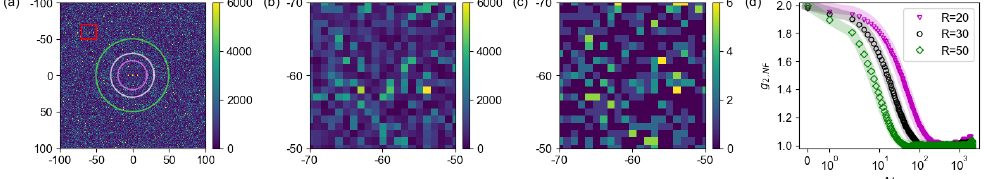
Figure 1. ( a ) The 100-th “noise-free” speckle pattern generated from the Fourier transform of the 2D diffusion simulation. Three annular ROIs were plotted with a radius of R = 19 ∼ 21 (purple), R = 29 ∼ 31 (gray) and R = 49 ∼ 51 (green) respectively. We refer to these ROIs as R = 20, R = 30 and R = 50 hereafter in the texts and in the legends. The R = 30 ROI will be used in the XPCS analysis in Figures 2–7. ( b ) A zoomed-in view of the red boxed area from the speckle pattern in ( a ). ( c ) The speckle pattern simulated with an overall intensity scaling α of 0.001 from ( b ) using Poisson statistics. ( d ) The g 2 calculated from the three ROIs, and the corresponding fits to the g 2 ’s are overlaid with the shaded lines. For the rest of the paper, only the R = 30 (gray) ROI is used.